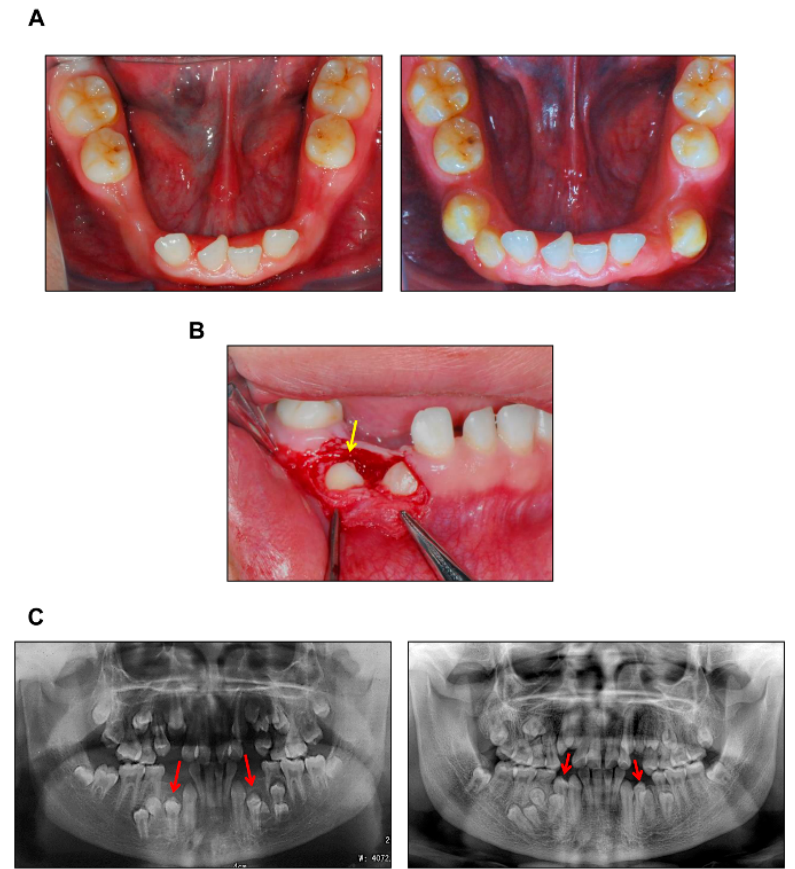
Figure 1. Guided eruption surgery of CCD patient. ( A ) Intraoral photographs of CCD patient #5. Left, pre-treatment, 12-year-old; Right, post-treatment, 19-year-old. ( B ) Surgical exposure of the impacted teeth, 16-year-old. Arrow: right mandibular first premolar. ( C ) Panoramic radiographs of CCD patient #5. Left, pre-treatment, 12-year-old; Right, post-treatment, 19-year-old. Arrows: mandibular first premolars.